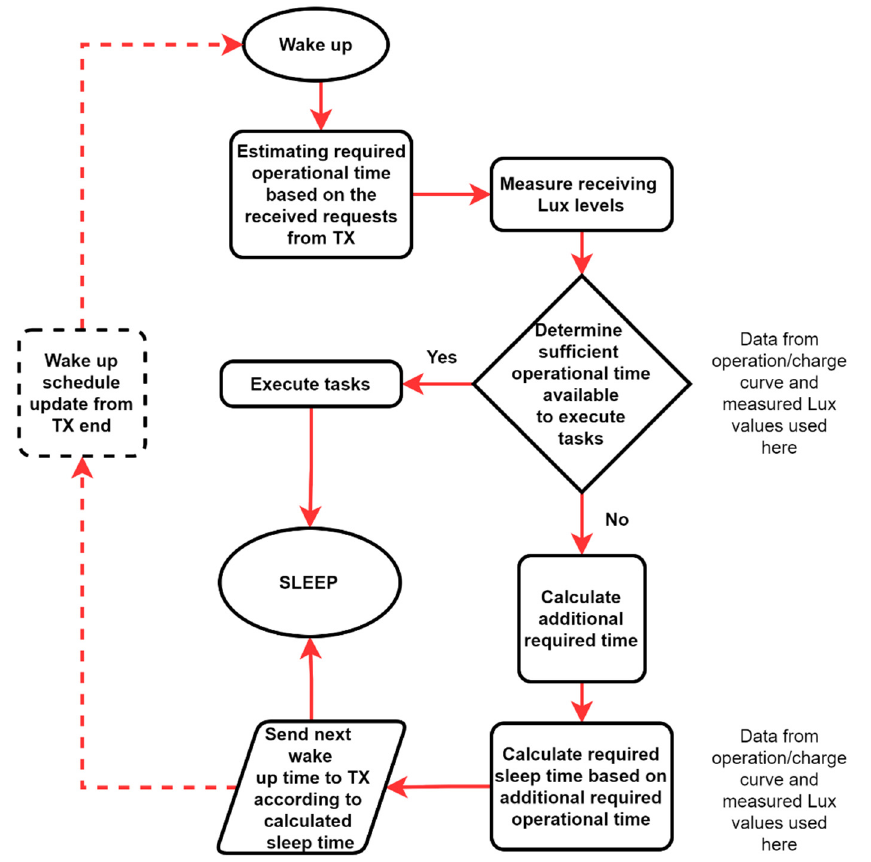
Figure 16. Proposed algorithm for Smart LIoT .